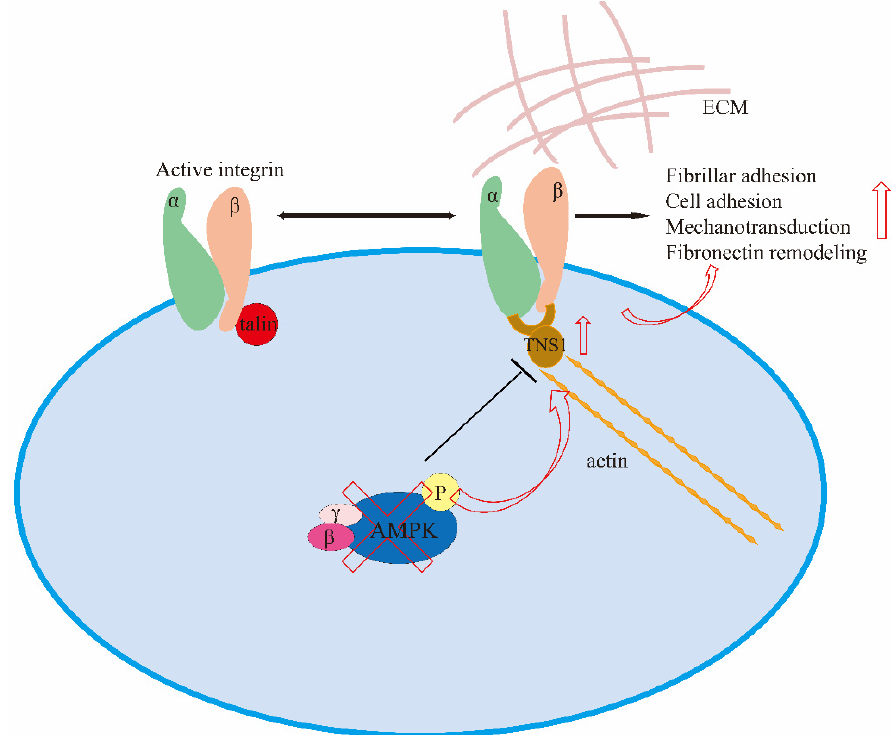
Figure 3. Mechanisms of AMPK-regulated fibrillar adhesion, cell adhesion, mechano-transduction, and fibronectin remodeling through the targeting of TNS1. and fibronectin remodeling through the targeting of